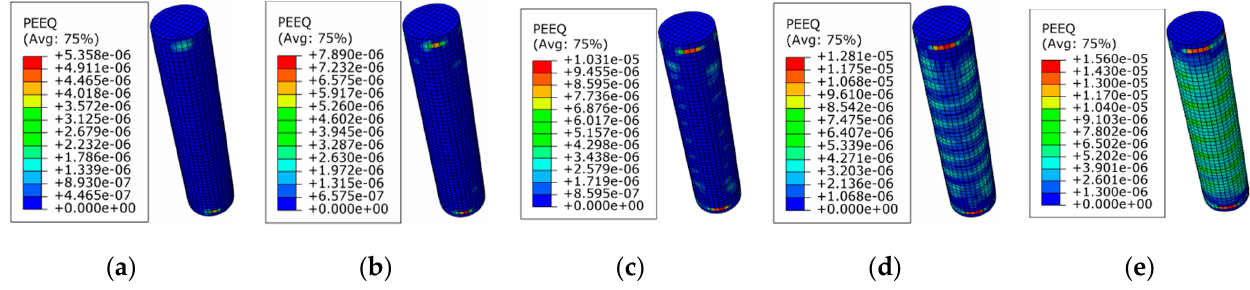
Figure 9. Cloud diagram around failure starting point: ( a ) F = 733 kN; ( b ) F = 750 kN; ( c ) F = 766 kN; ( d ) F = 782 kN; ( e ) F = 797 kN.